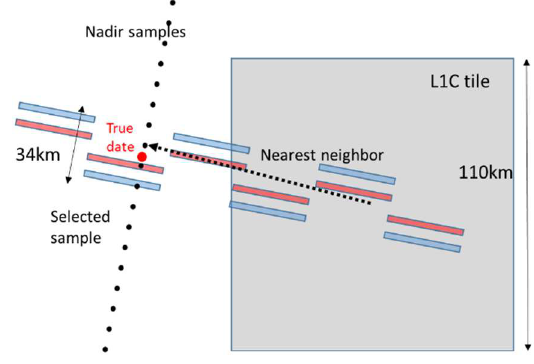
Figure 16 : Nadir sample selection associated to a L1C